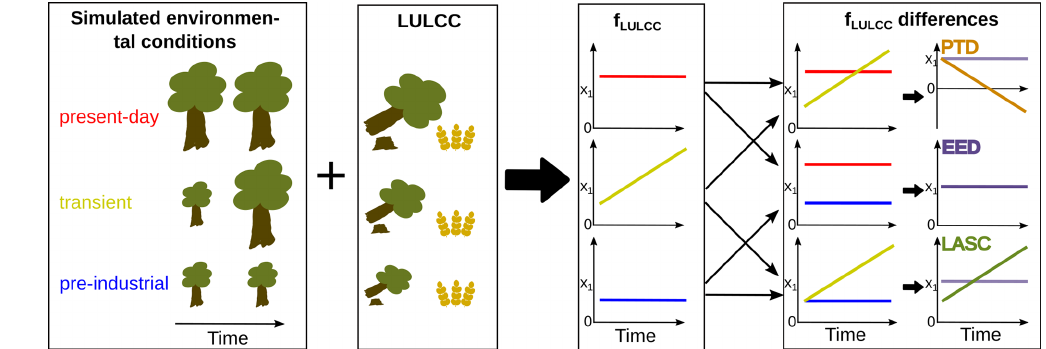
Figure 1. Illustration of the different f LULCC estimations and their differences. The altered sizes of trees (box 1) indicate that vegetation responds to the historical trends in environmental conditions (such as increased CO 2 levels and global warming). Historically and globally, environmental changes led to an increase in land C stocks, therefore present-day environmental conditions are associated with taller trees in our scheme. When a LULCC occurs that reduces C stocks (box 2) the higher C stocks will cause a higher f LULCC (box 3: red line (present- day) higher than blue line (pre-industrial); yellow line (transient) increasing with time). The f LULCC is derived by subtracting the net biome productivity from a simulation without LULCCs from one with LULCCs. Additionally, the different f LULCC estimations can be compared to each other (box 4): the loss of additional sink capacity (LASC; green line; Eq. 4), environmental equilibrium difference (EED; purple line; Eq. 5), and “present-day” vs. “transient” environmental conditions difference (PTD; orange line; Eq.